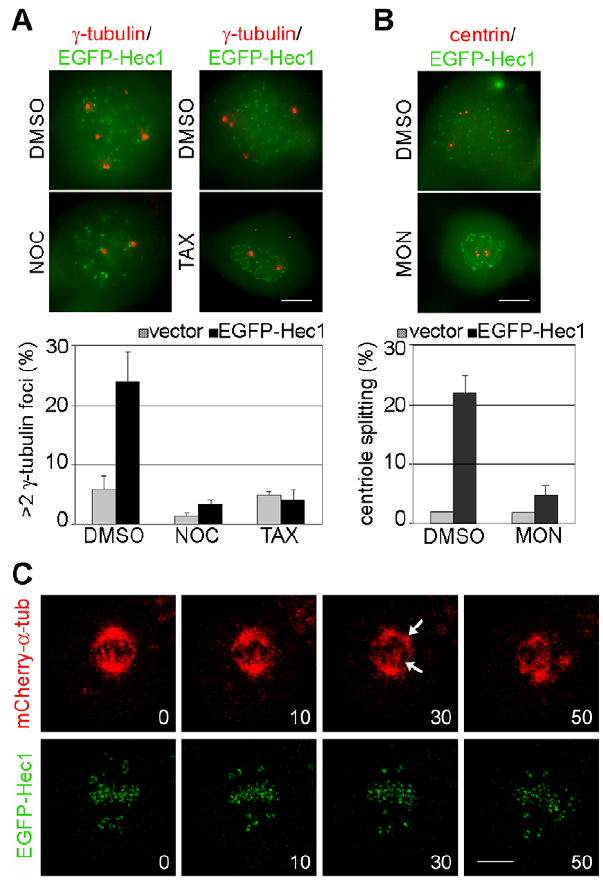
Figure 4. Spindle pole fragmentation is due to an unbalance of forces within the mitotic spindle. (A) Merged image of EGFP-Hec1 (green) expressing prometaphases stained for c -tubulin (red) after incubation with nocodazole (NOC), taxol (TAX) or DMSO for the last 4 h expression time. Only 2 c -tubulin signals are present after NOC or TAX treatment in the EGFP-Hec1 cells. The graph shows the mean percentage ( 6 SE) of mitotic cells with . 2 c -tubulin foci in vector or EGFP-Hec1 cells treated with NOC, TAX or DMSO (n=200 from duplicate assays). (B) Merged image of EGFP-Hec1 (green) expressing prometaphases stained for centrin (red) after incubation with monastrol (MON) or DMSO for the last 4 h expression time. The graph shows the mean percentage ( 6 SE) of mitotic cells with splitted centrioles in vector or EGFP-Hec1 cells treated with MON or DMSO (n=200 from duplicated assays). (C) HeLa cells cotransfected with EGFP-Hec1 (green) and mCherry- a -tubulin (red) vectors were recorded by time-lapse microscopy during mitosis. mCherry- a -tubulin shows that the late prometaphase showing many unaligned KTs initially possessed a bipolar spindle (0). KTs attempted to congress within the bipolar spindle (10), but, then, two supernumerary spindle poles appeared under mCherry-tubulin fluorescence (30, arrows). Spindle poles successively moved apart and the KTs re-organized within the multipolar spindle (50). Time is given in min. Bars, 5 m